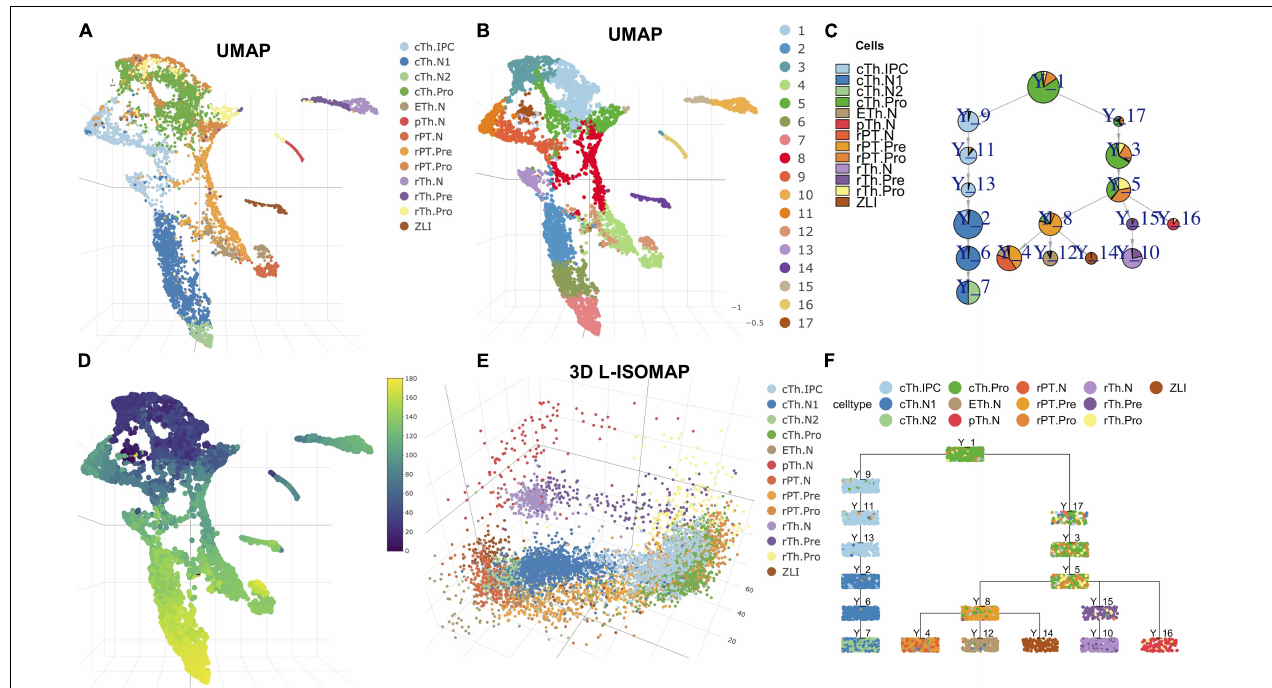
FIGURE 2 | Cell trajectory of mouse diencephalon at E12.5. (A) UMAP visualization of cell types. (B) Clustering results shown in UMAP. (C) Pie tree plot shows the cell types and trajectory. (D) The pseudotime distribution in UMAP. (E) Diencephalon cell differentiation in 3D L-ISOMAP. (F) Cell cluster tree plot shows the differentiation trajectory of the diencephalon (each box is a cluster marked by Y_cluster ID, each point represents a cell). The cell type names are as follows. rTh.pro, rostral thalamic neurons progenitor; rTh.pre, rostral thalamic neurons precursor; rTH.N, rostral thalamic neurons; rPT.Pro, rostral pretectal neural progenitor; rPT.pre, rostral pretectal neural precursor; rPT.N, rostral pretectal neurons; cTh.Pro, caudal thalamic neural progenitor; cTh.IPC, caudal thalamic intermediate progenitor; cTh.N1, caudal thalamus neuron I; cTh.N2, caudal thalamus neuron II; pTh.N, prethalamic neurons; ETh.N, epithalamic neurons; ZLI, zona limitans